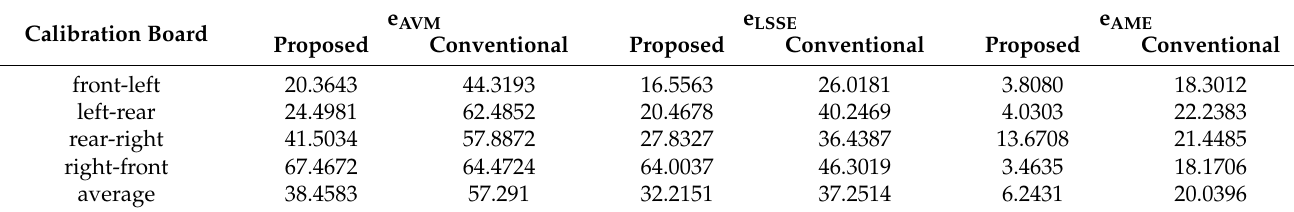
Table 5. AVM errors in the proposed method and the conventional